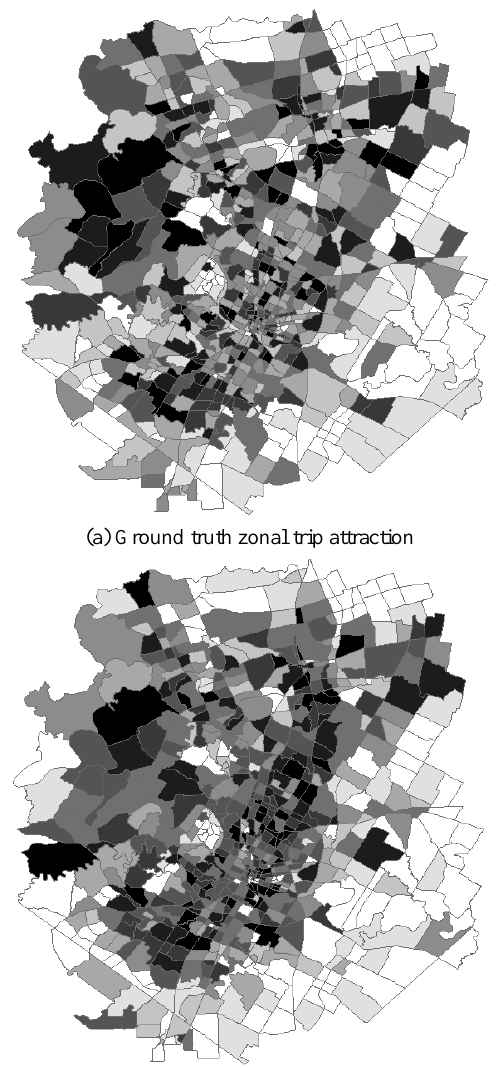
Figure 7. Zonal daily trip attraction heat